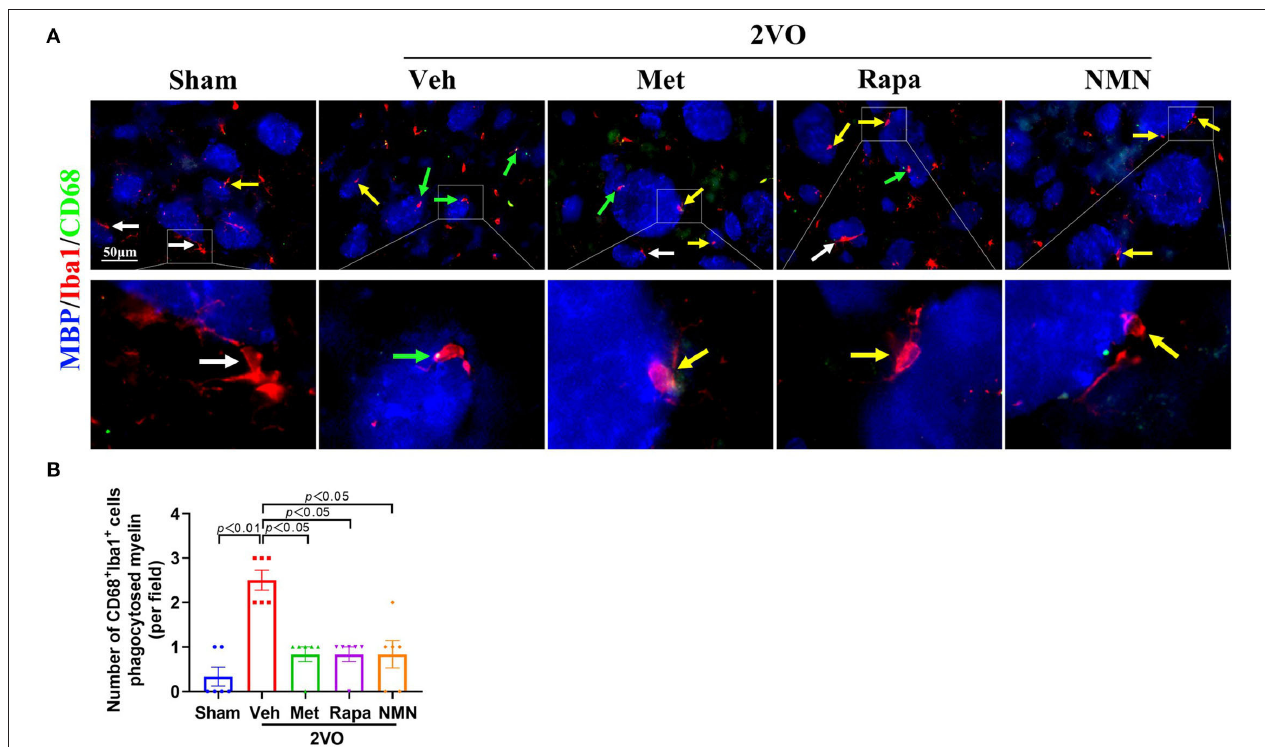
FIGURE 5 | Metformin, rapamycin, or NMN pretreatment alleviates microglial phagocytosis of myelin in the striatum after BCCAO. (A) Photomicrographs of triple immunofluorescent staining for Iba1 (red), CD68 (green), and MBP (blue). White arrows indicate Iba1 + microglia. Yellow arrows indicate Iba1 + CD68 + microglia. Green arrows indicate Iba1 + CD68 + MBP + microglia. (B) Quantification of CD68 (green), Iba1 (red), and MBP (blue)-positive cells in the striatum of sham-operated and BCCAO rats pretreated with vehicle (Veh), metformin (Met), rapamycin (Rapa), or NMN (NMN) for 2 weeks before surgery. The p -values were assessed by the Kruskal–Wallis test with a Dunn post-test. All data were shown as mean ± SEM. N = 6 per group. 2VO, two-vessel